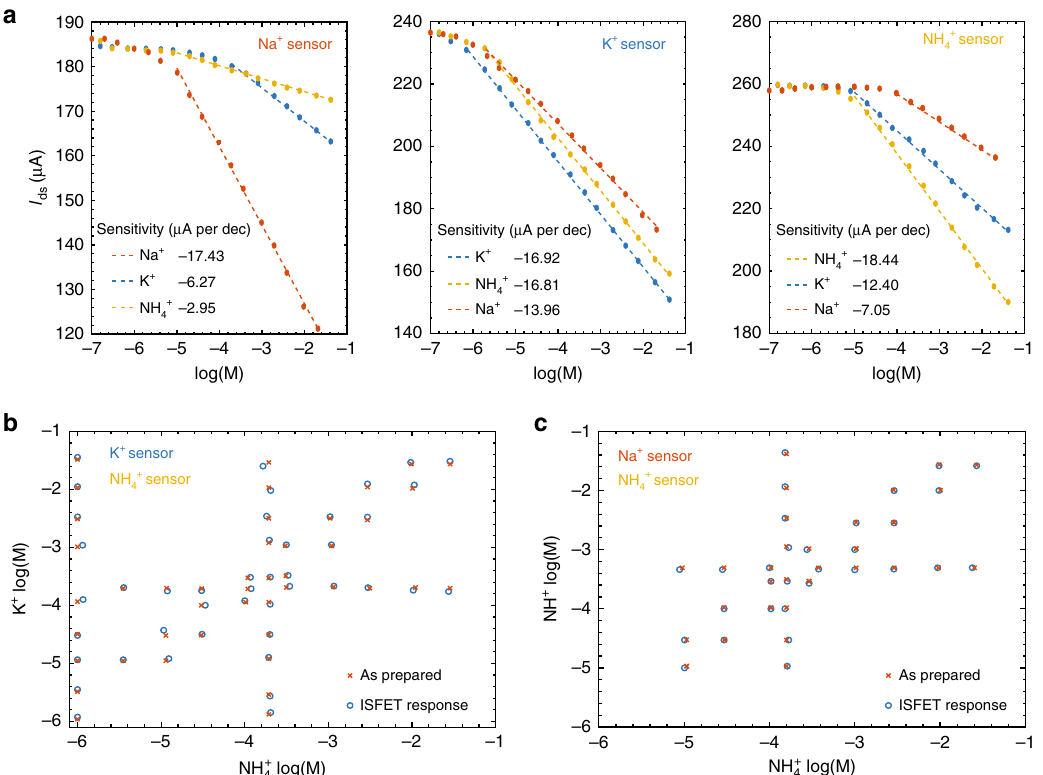
Fig. 5 Overcoming ISFET cross sensitivities. a The changes in I ds for the different cation ISFETs with respect to concentrations of the cations, using the separate solution method. Linear fi ts were used to extract the Nikolskii selectivity coef fi cients. b Comparison of the measured K + and NH þ by applying the Nikolskii-Eisenman formalism and the as prepared concentrations. The as prepared concentrations are determined from the solution volume and mass of the added salts. c Comparison of the measured Na + and NH þ prepared